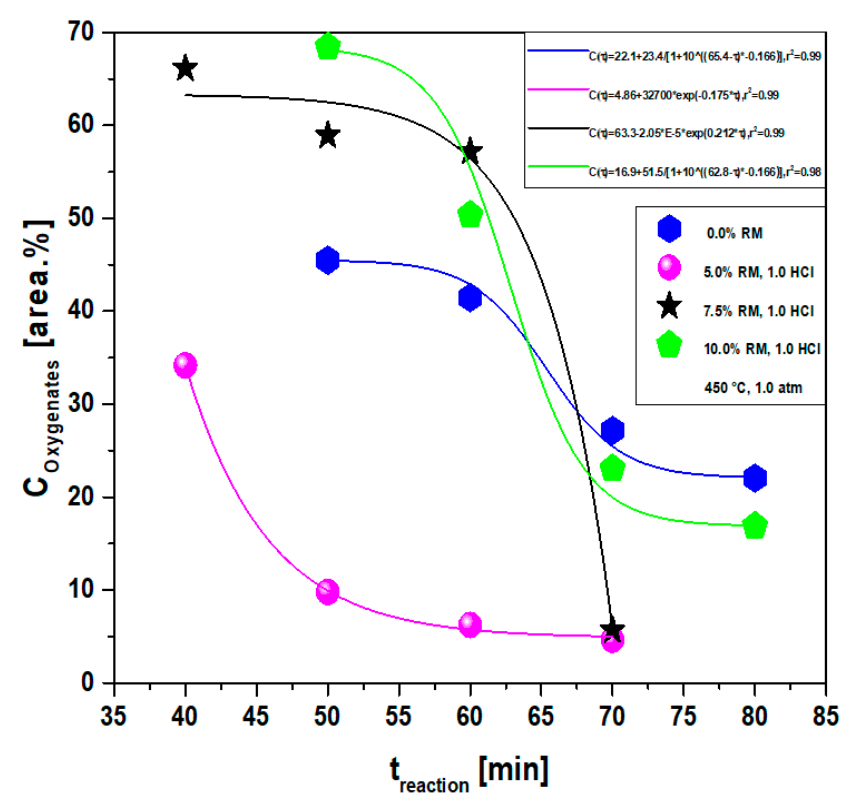
Figure 19. Effect of reaction time on the content of oxygenates by the upgrading of residual fat pyrolysis vapors at 450 ◦ C, 1.0 atmosphere, 0.0, 5.0, 7.5, and 10.0% (wt.) red mud pellets pyrolysis vapors at 450 °C, 1.0 atmosphere, 0.0, 5.0, 7.5, and 10.0% (wt.) red mud pellets activated with 1.0 M HCl, using a catalyst fixed bed reactor, using a semi-pilot scale two-stage reactor of 2.0 L.